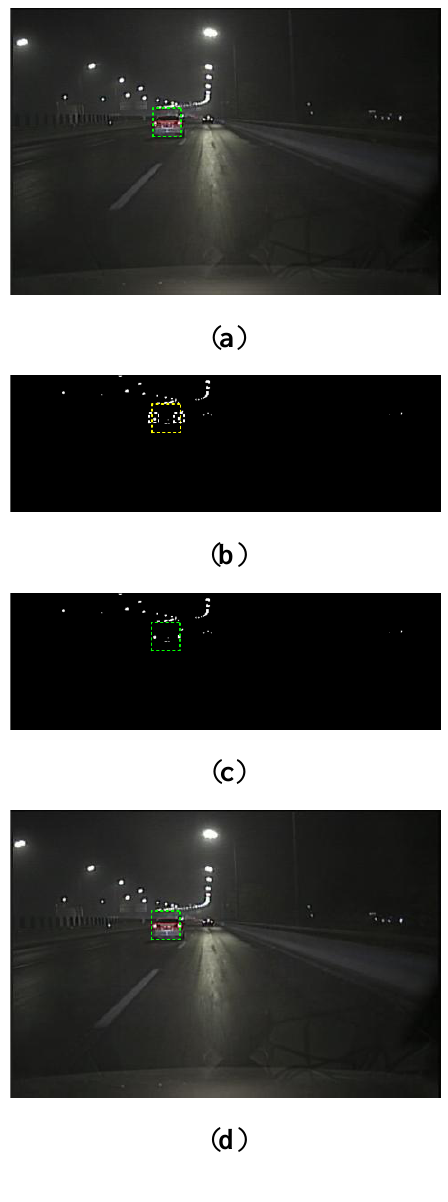
Figure 7. Procedure of vehicle tracking: ( a ) Vehicle detection result at time k ; ( b ) Predicted location at time k + 1 based on Kalman filtering and taillight spot extraction; ( c ) Vehicle estimation based on extracted taillight; ( d ) Vehicle detection result at time k +